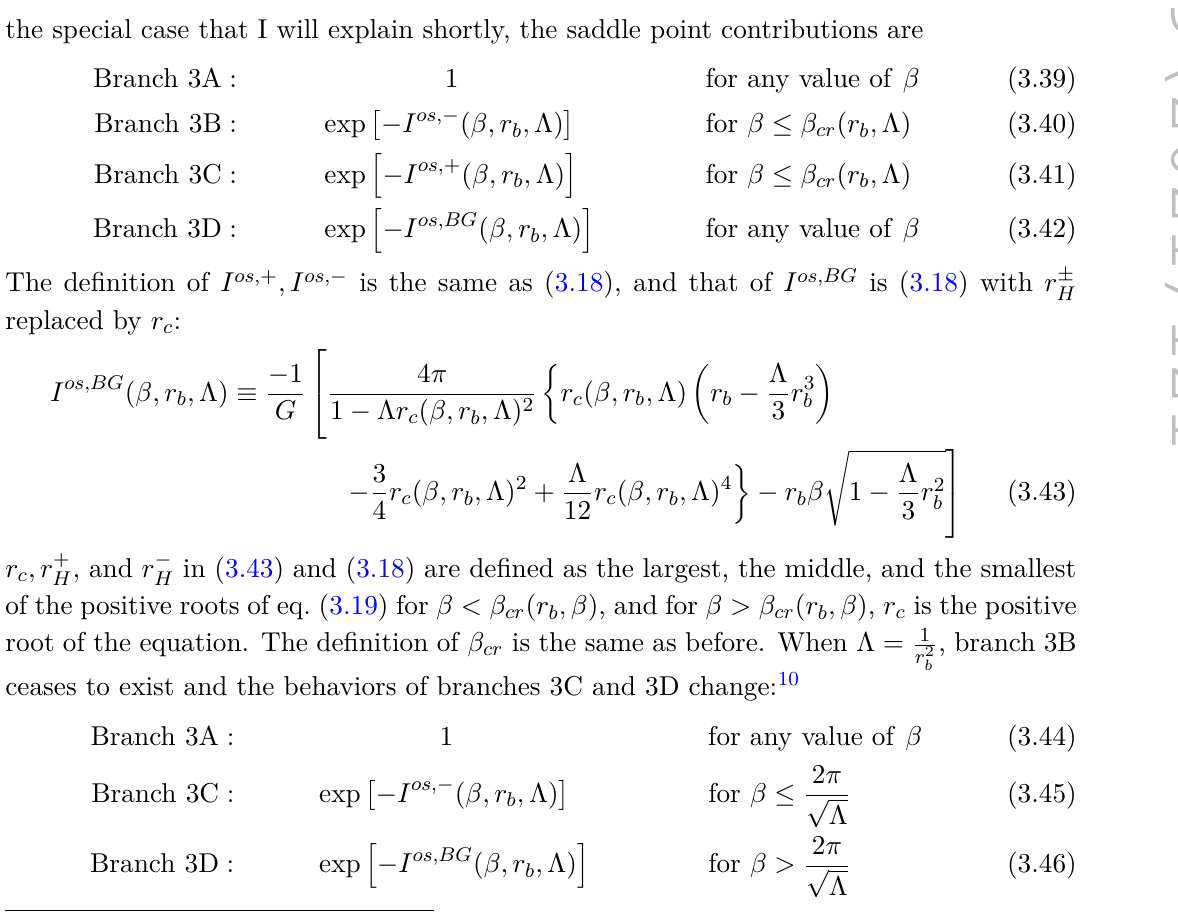
. For fixed r , r can be arbitrarily large depending b c b